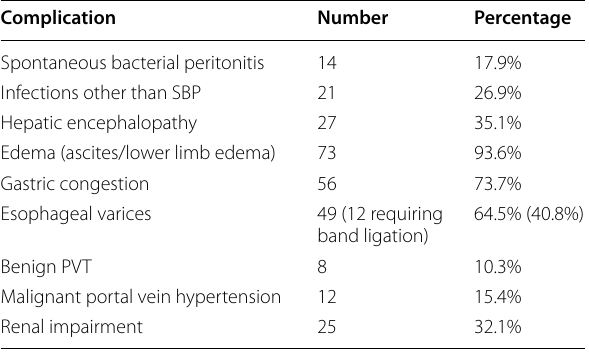
Table 2 Percentages of liver cirrhosis complications reported in our study group